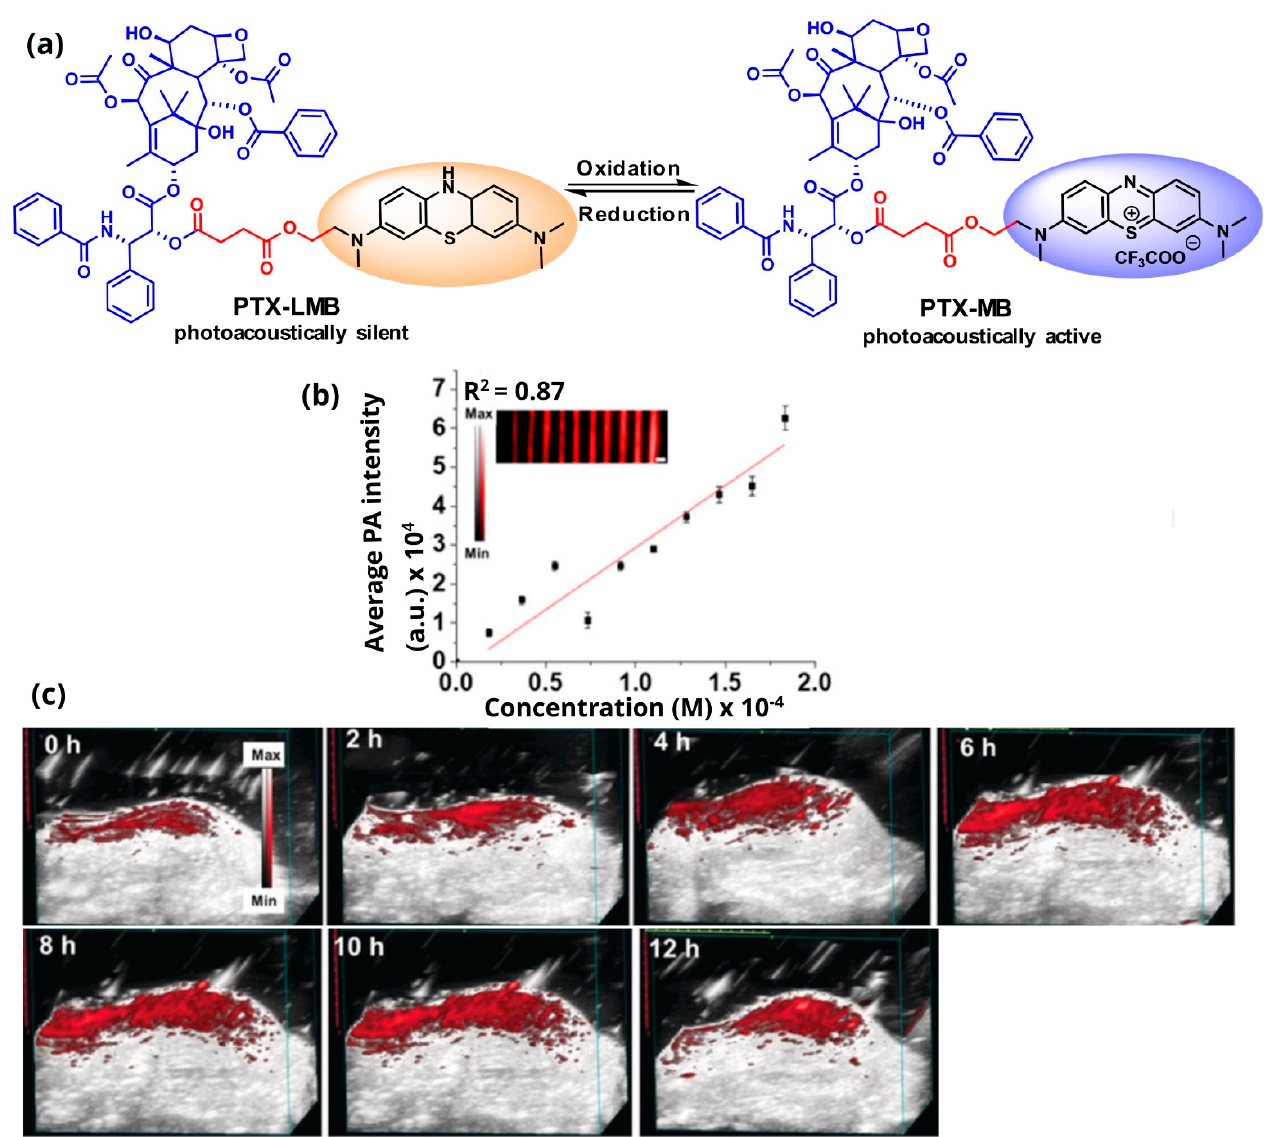
Figure 9. ( a ) Schematic diagrams of the mechanism of action of the PTX-MB conjugate; ( b ) presentation of the positive increase in the photoacoustic signal of the PTX-MB conjugate; ( c ) photoacoustic images after the subcutaneous injection of mice over time and the photoacoustic signal intensity increase at 0–8 h. Adapted with permission from [116], John Wiley and Sons, 2020.